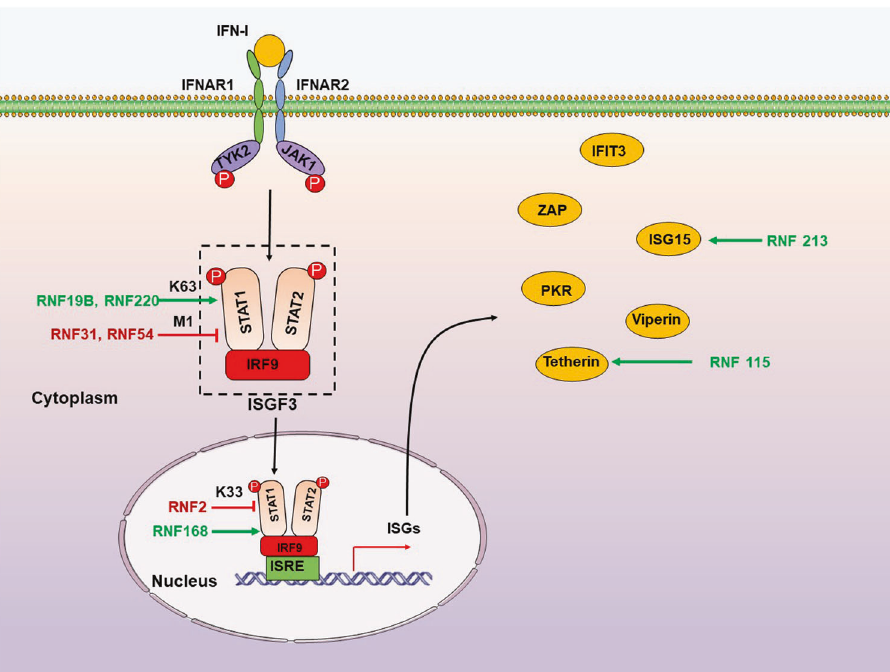
Fig. 5 RNF proteins regulate the JAK-STAT signaling pathway and its downstream ISGs. The antiviral activities of IFN-I are initiated by binding to their cognate receptor IFNAR1 and IFNAR2 to trigger a signaling cascade, namely JAK-STAT pathways. The activated JAKs then trigger the assembly of the ISGF3 complex, which imports into the nucleus to bind ISRE for ISG production. RNF proteins are responsible for positively (green arrows) or negatively (red T-shaped solid line) modulating the JAK-STAT signaling pathway and its downstream ISGs. P,